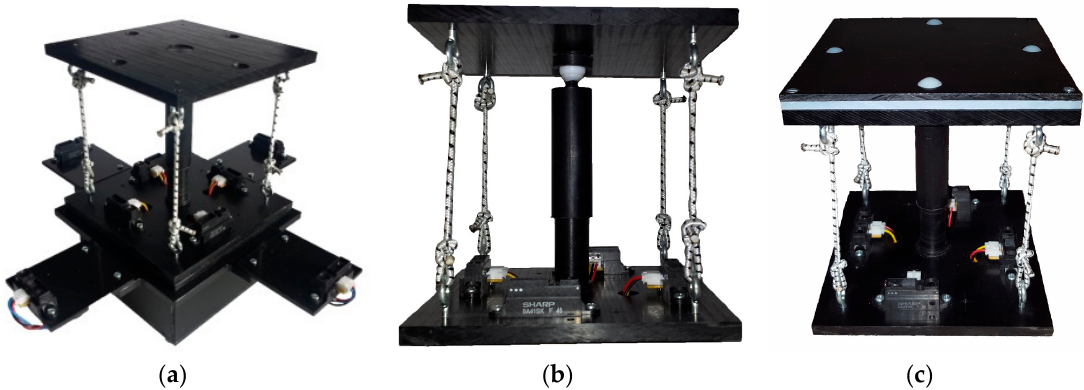
Figure 3. ( a ) Mechanical assembly of compliant wrist prototype; ( b ) detailed view of compliance stage with compression/tension mechanisms and internal infrared range sensor array; and ( c ) wrist with additional contacting layer.